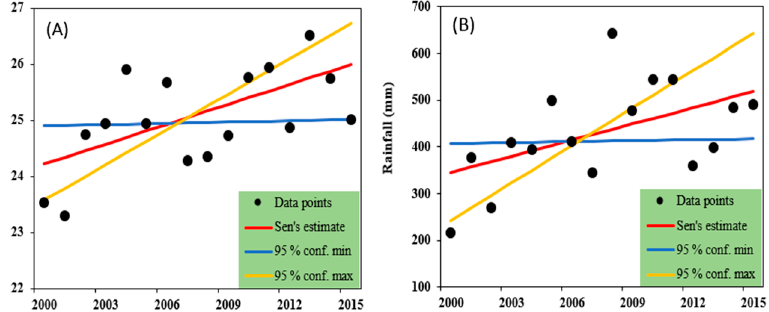
Figure 8. Trend analysis of Mann–Kendall test and Sen’s slope estimator for temperature ( A ) and precipitation ( B ) during 2000–2015.